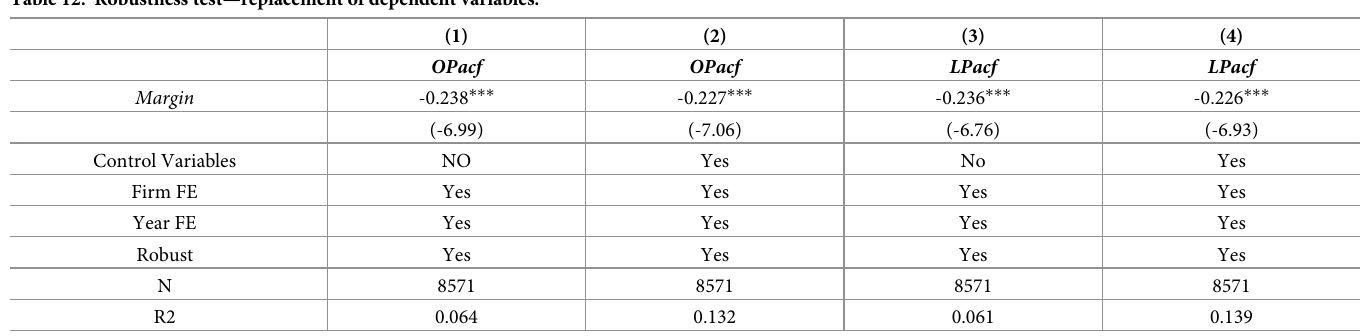
Table 12. Robustness test—replacement of dependent variables.